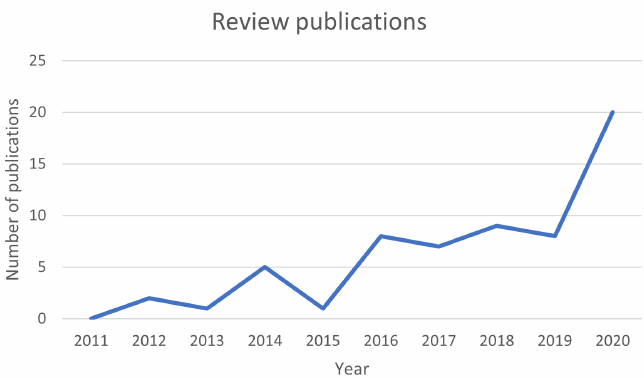
Figure 4. Evolution of reviewed publications of the last